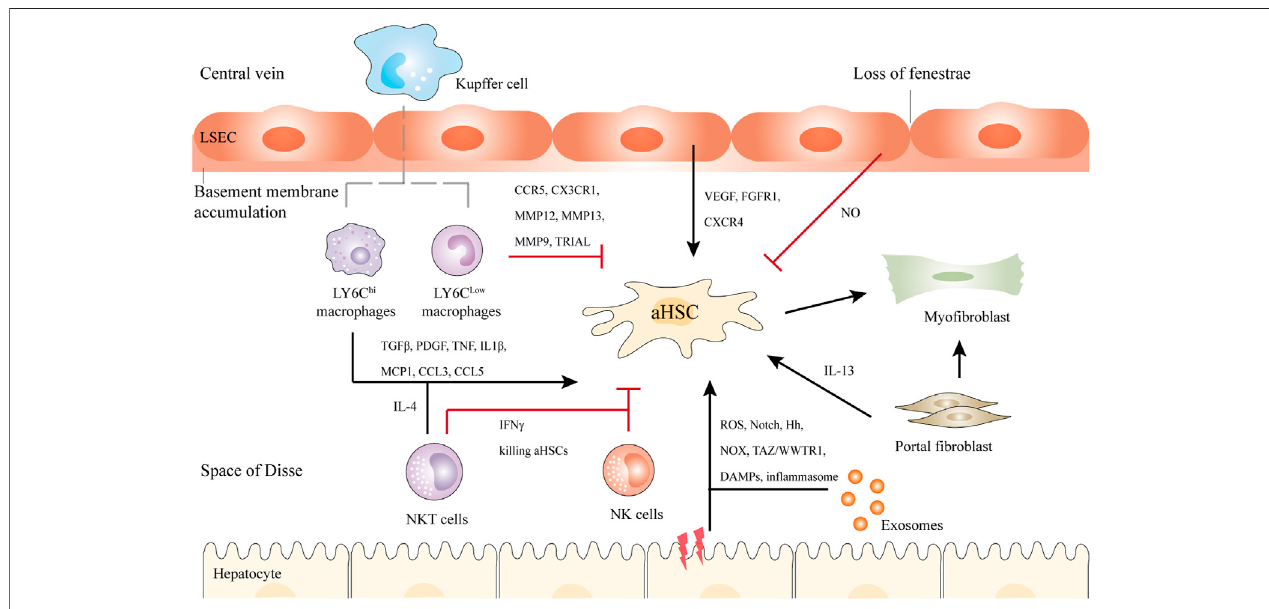
FIGURE 2 | Schematic illustration of the crosstalk between HSCs and Kupffer cells, NK cells, NKT cells, hepatocytes, bone marrow-derived macrophages, and LSECsinliver fi brosis. Brie fl y,uponliverinjury,hepatocytesundergodamage,andin fl ammatory,releasingDAMPs, exosomes, etc.LY6C hi macrophagesactivateHSCs by TGF β , IL1 β , and other cytokines, while LY6C low macrophages show anti fi brotic ability via CX3CR1, MMP12, MMP13, etc. NKT cells and NK cells secret IFN γ to kill aHSCs. NKT cells can also activate HSCs through IL-4. In addition, LSECs undergo capillarization and accumulation of basement membranes. They can promote either liver regeneration or fi brosis. Another population of myo fi broblasts is the portal fi broblasts, which can also activate HSCs in cholestatic liver. Black and red arrows represent promotion or inhibition of aHSCs respectively.